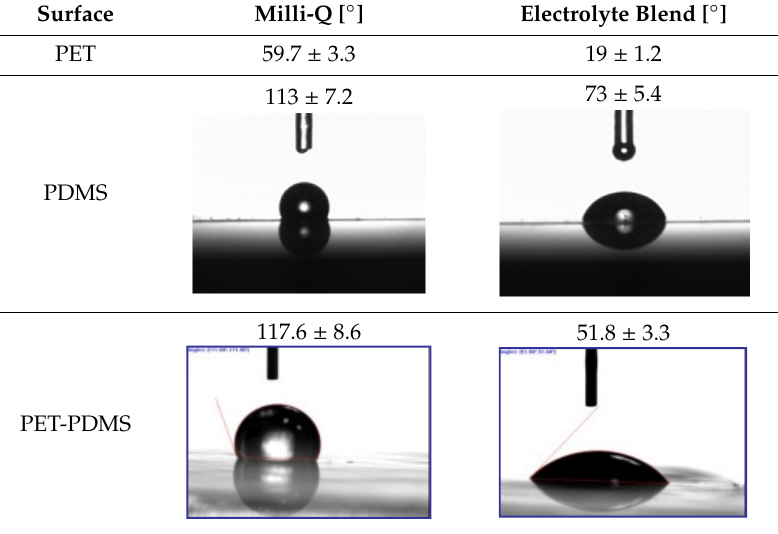
Table 2. The contact angles of Milli-Q water and a mixed electrolyte solution (0.05 M TMACl + 0.05 M NaDBS) on various surfaces. TMACl solutions without NaDBS had very similar values to pure Milli-Q.